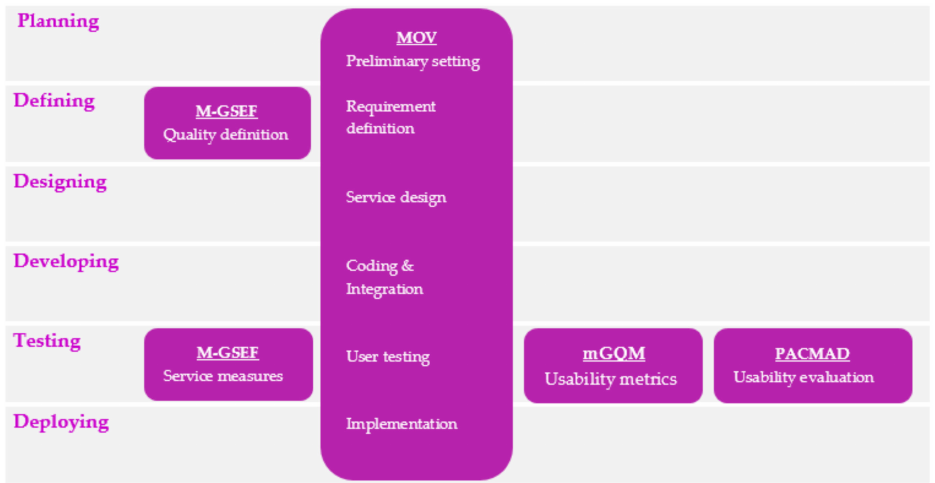
Figure 1. Relationships of the existing usability-design-related frameworks and